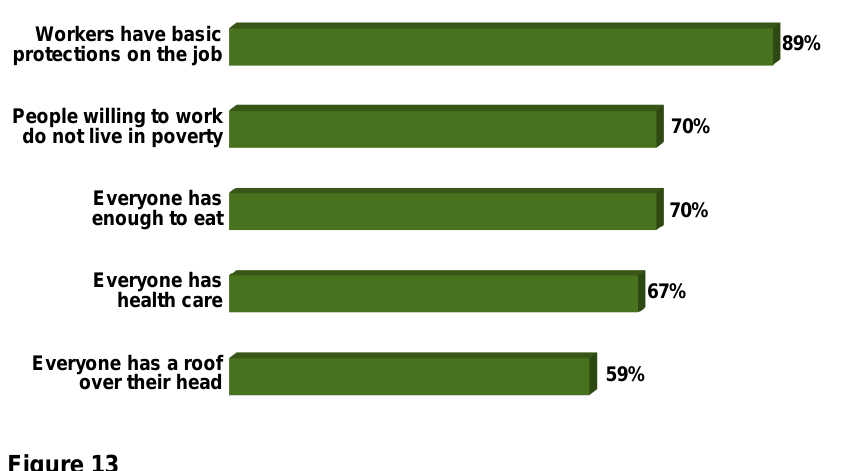
Workers have basic protections on the job People willing to work do not live in